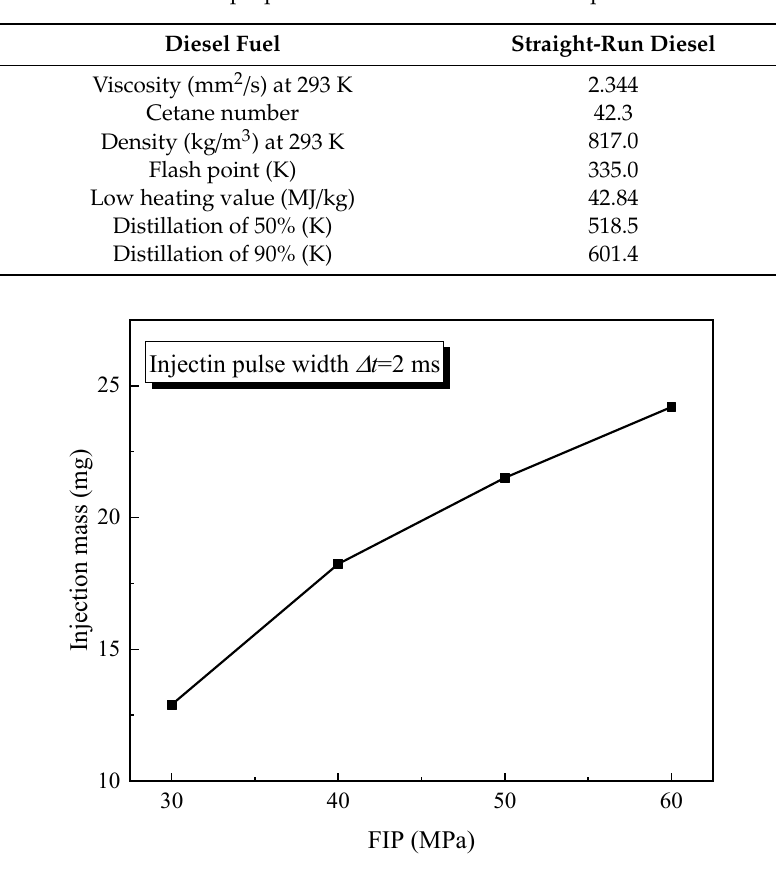
Figure 3. Calibration results of injection mass versus fuel injection pressure.